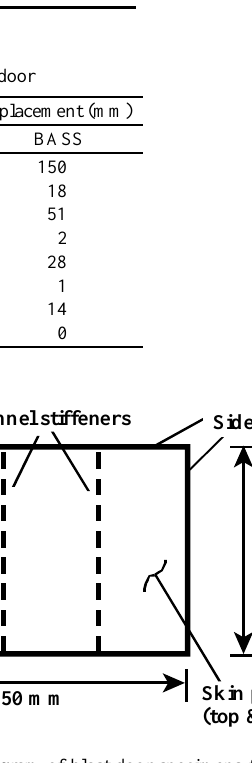
Fig. 12. Schematic diagram of blast door specimens for field tests (plan